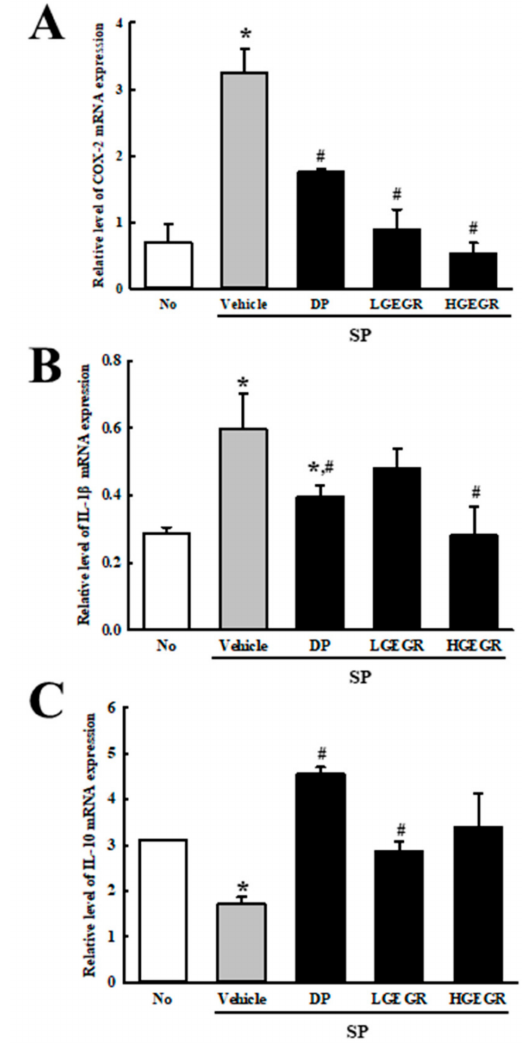
Figure 9. Measurement of inflammatory cytokines and their mediators in SP + GEGR treated mice. The levels of COX-2 ( A ), IL-1 β ( B ), and IL-10 ( C ) transcripts in the total mRNA of brain were measured by quantitative real time-PCR analyses using specific primers. The mRNA level of each gene was calculated based on the intensity of actin as an endogenous control. Three samples were assayed in duplicate by qRT-PCR analyses. The values of data represent the mean ± SD. * p < 0.05 compared with the No treated group. # p < 0.05 compared with the SP + Vehicle treated group. Abbreviation: DP, donepezil; GEGR, gallotannin-enriched extract of Galla Rhois; SP,